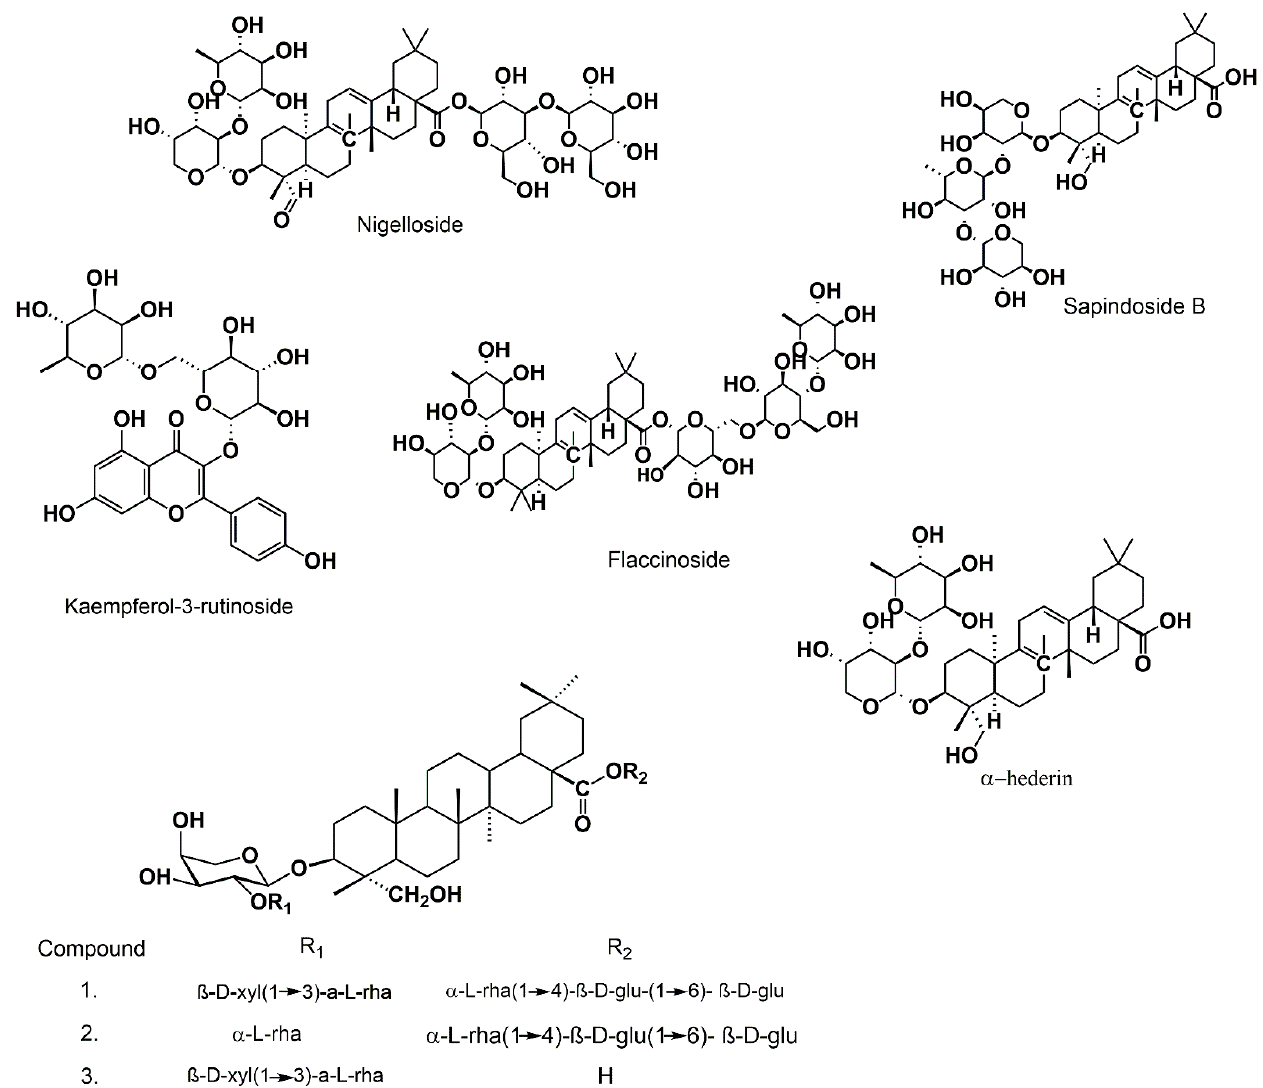
Figure 4. Some saponins isolated from the aerial part of NS .